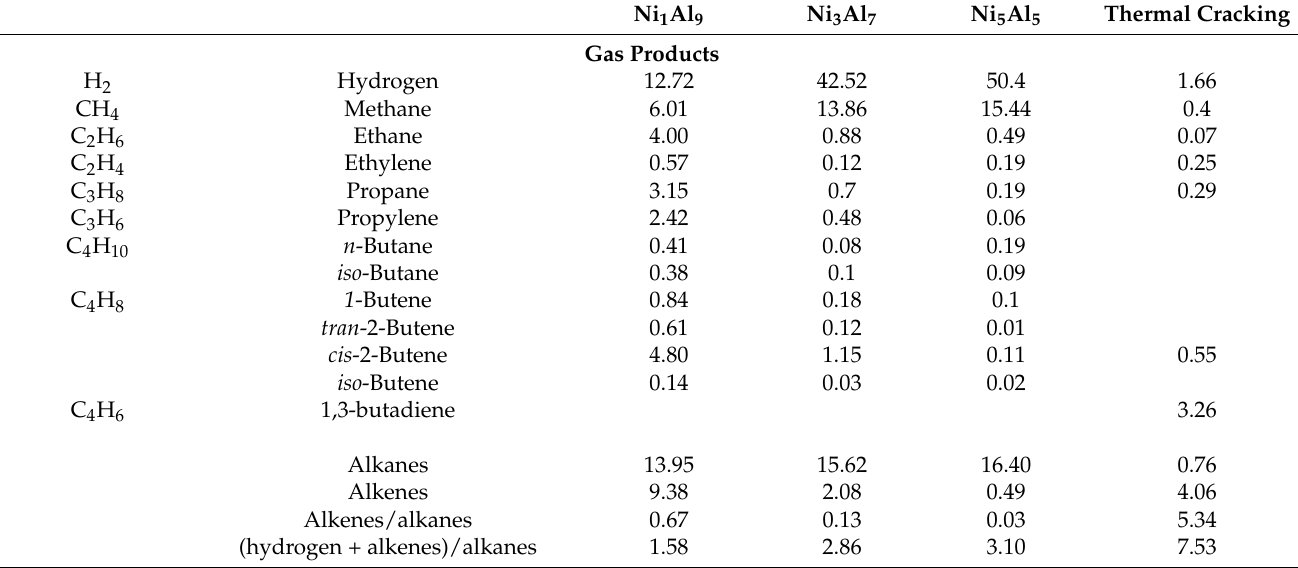
Table 5. Product distribution of methylcyclohexane (MCH) catalytic cracking based on H-mmol (%) and C-mmol